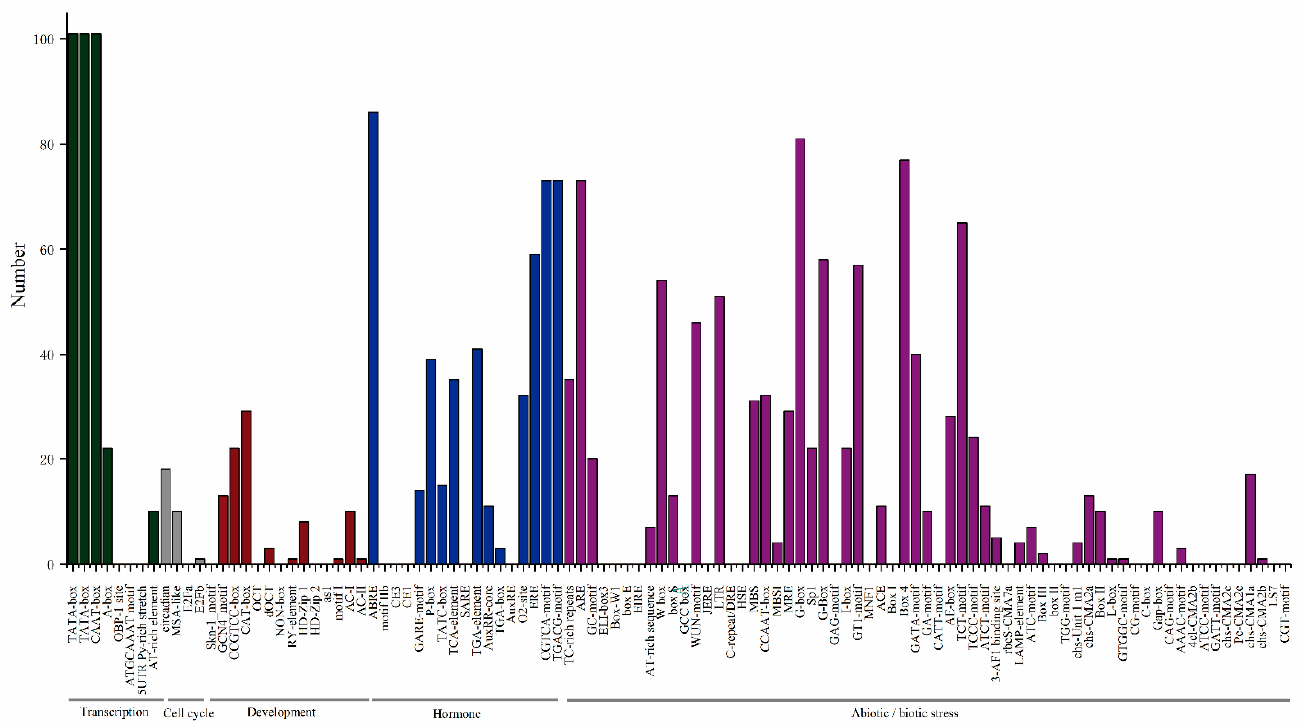
Figure 2. The distribution of various cis-acting elements in the promoter regions of Hypericum perforatum ERF genes ( HpERFs ). The cis-elements of HpERFs were searched using the online PlantCARE website. A graph is displayed according to the detected cis-elements relevant to specific elicitors/conditions/processes (x-axis) in the HpERF gene family members (y-axis).